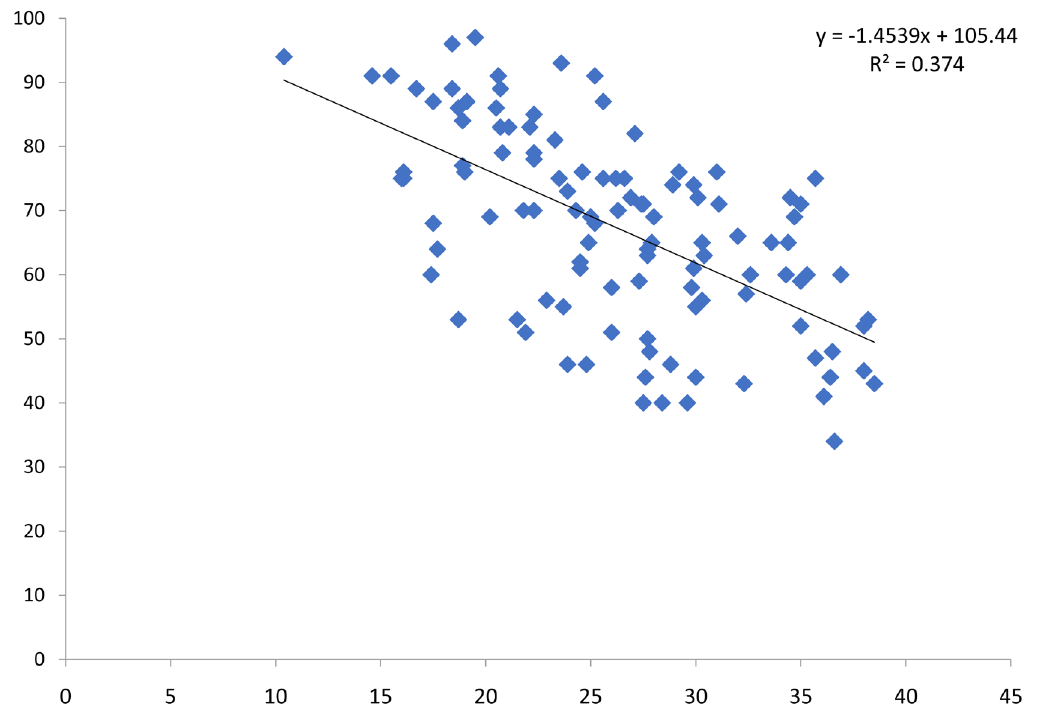
Figure 2. Correlation between implementation index and unmet need for family planning.